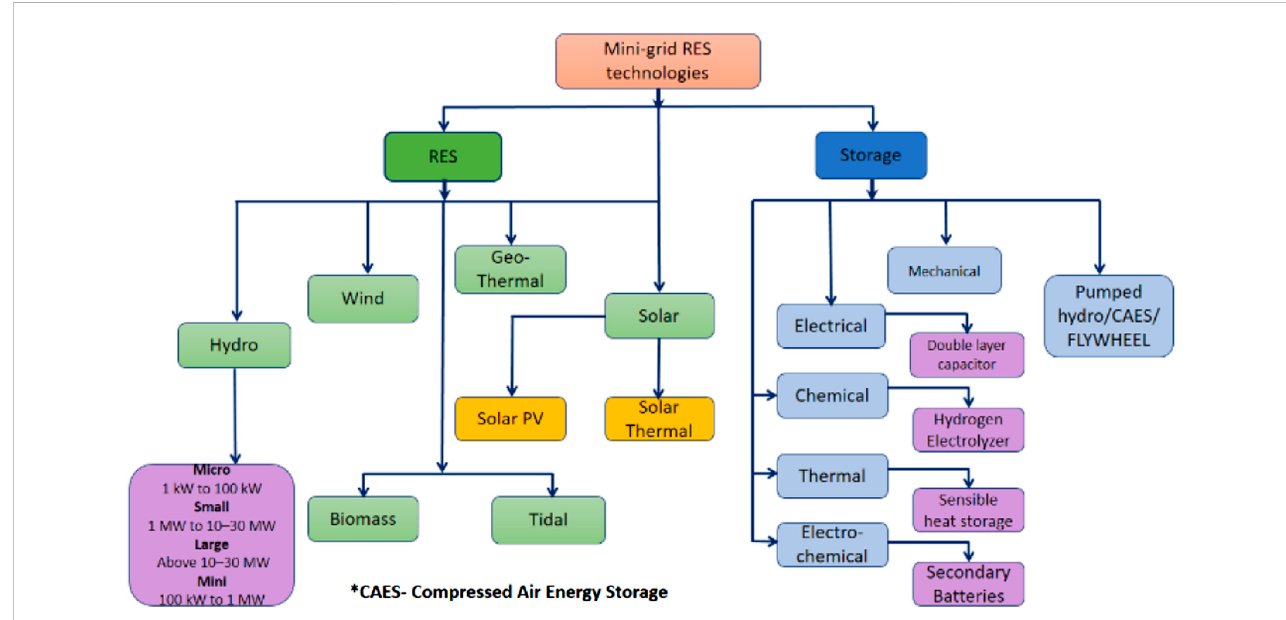
FIGURE 2 Integration of renewable mini-grids into the main